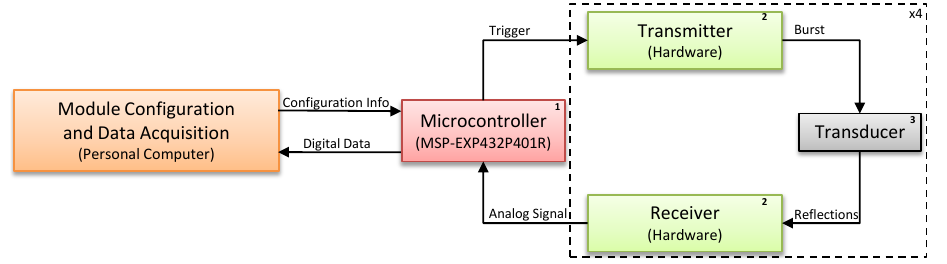
Figure 1. Multiple obstacle detection system block diagram.